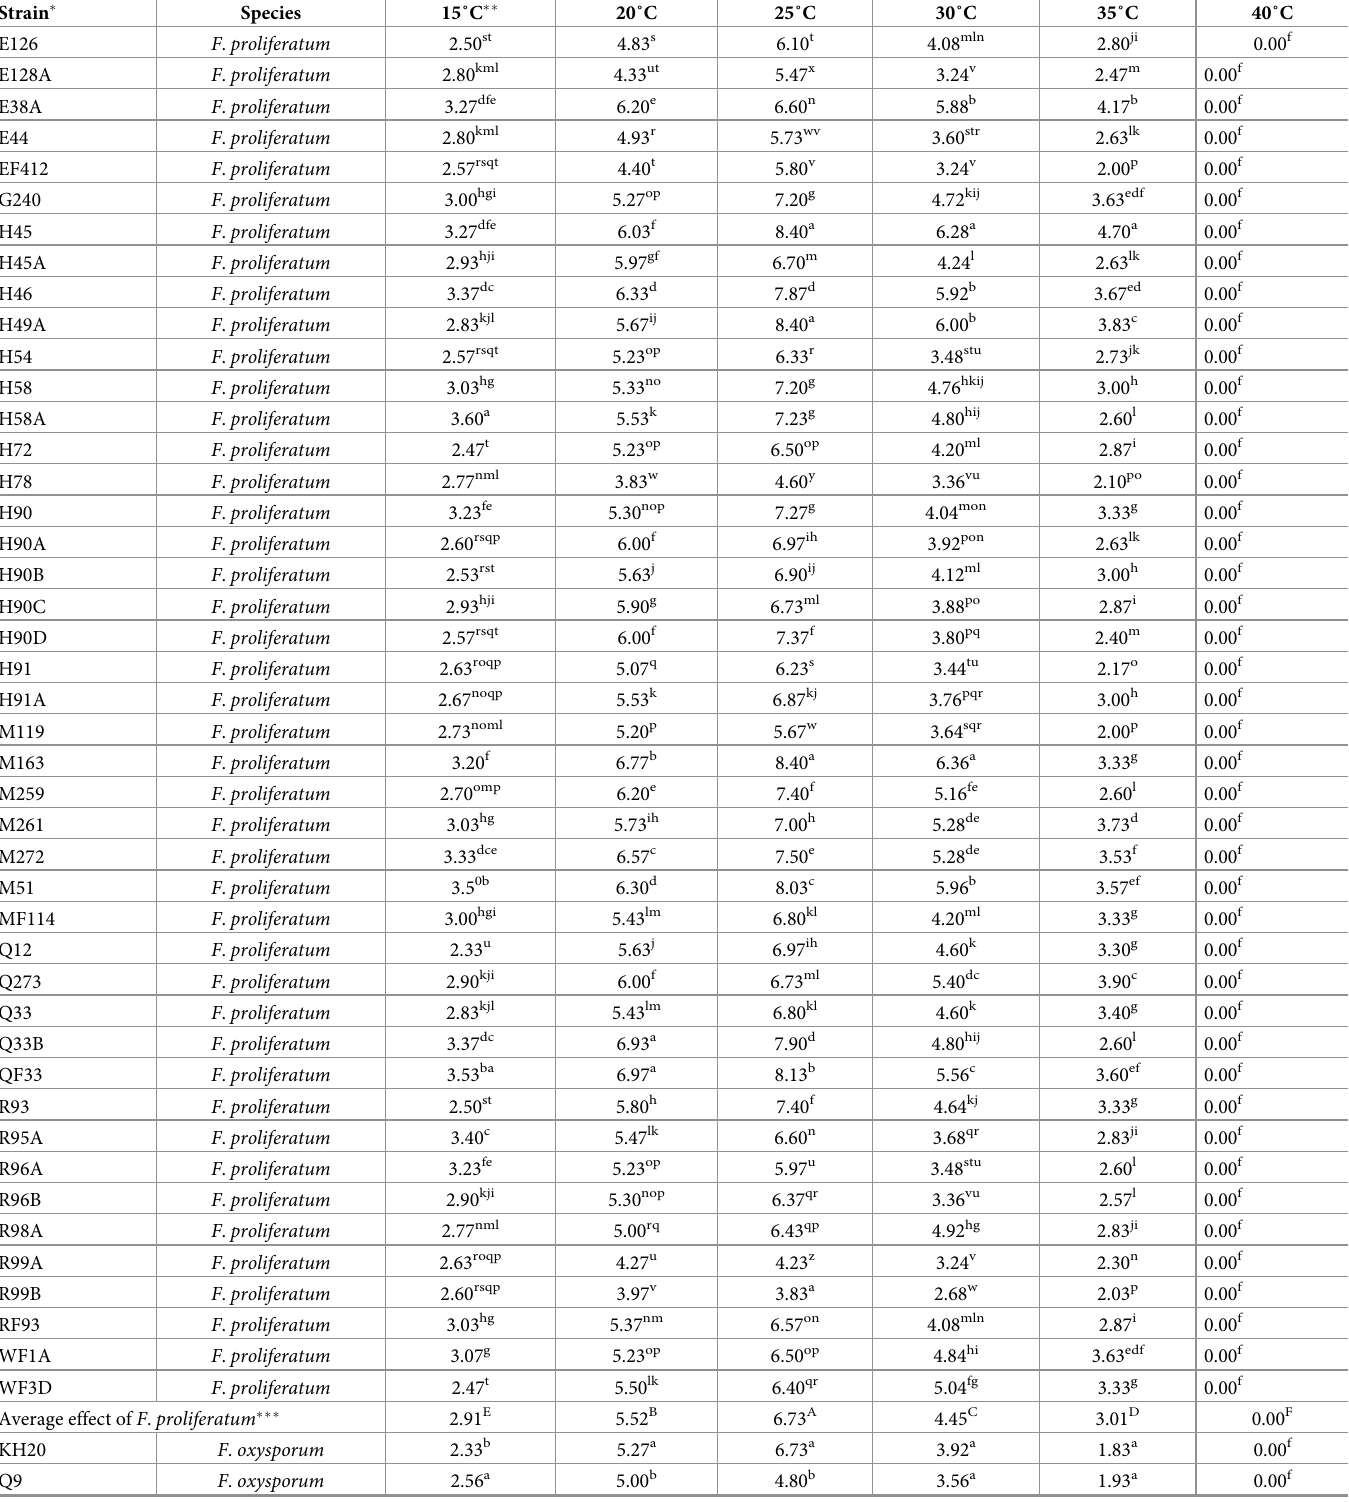
Table 2. Effect of different temperature on mycelial growth of Fusarium strains isolated from date palm trees in Saudi Arabia. Strain �